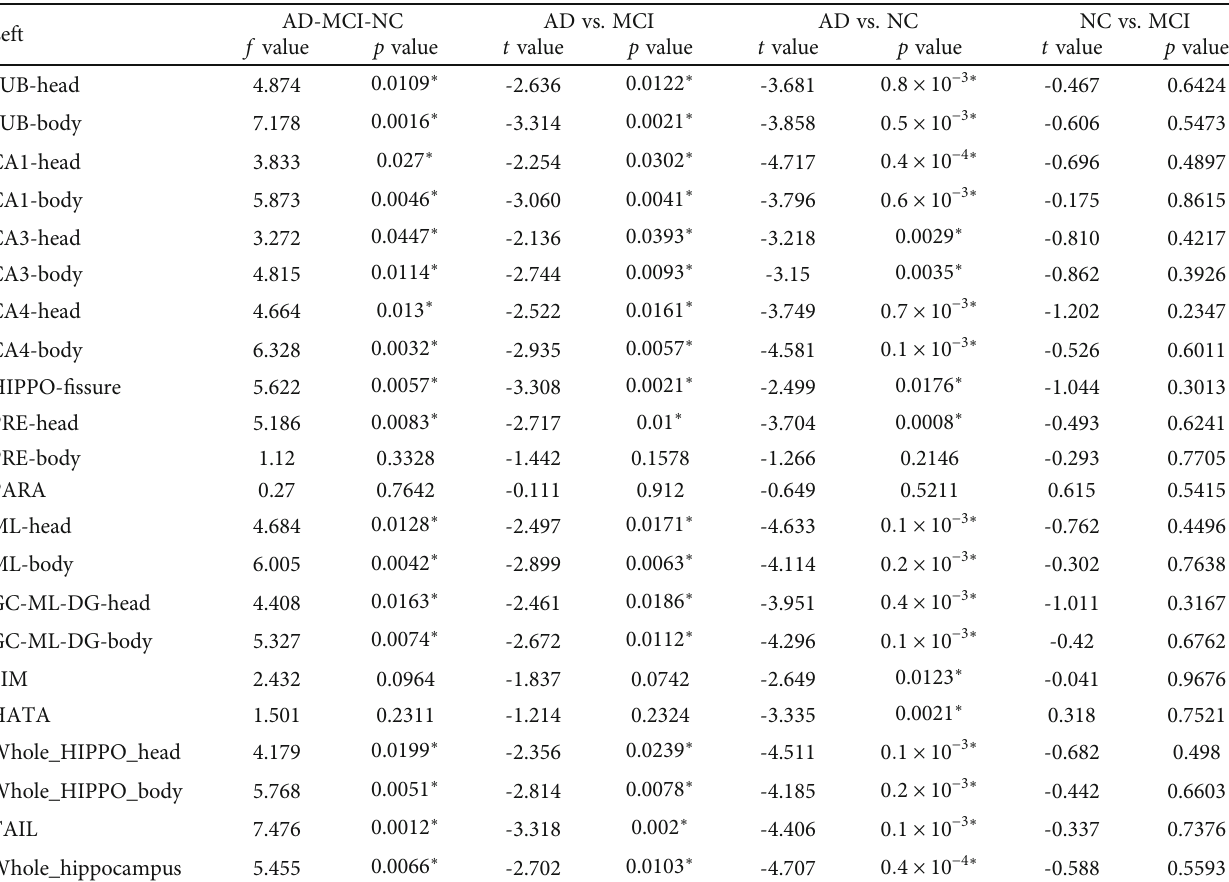
Table 4: ANOVA test and multiple comparison results of the subregion volumes of the left hippocampus between the three groups.